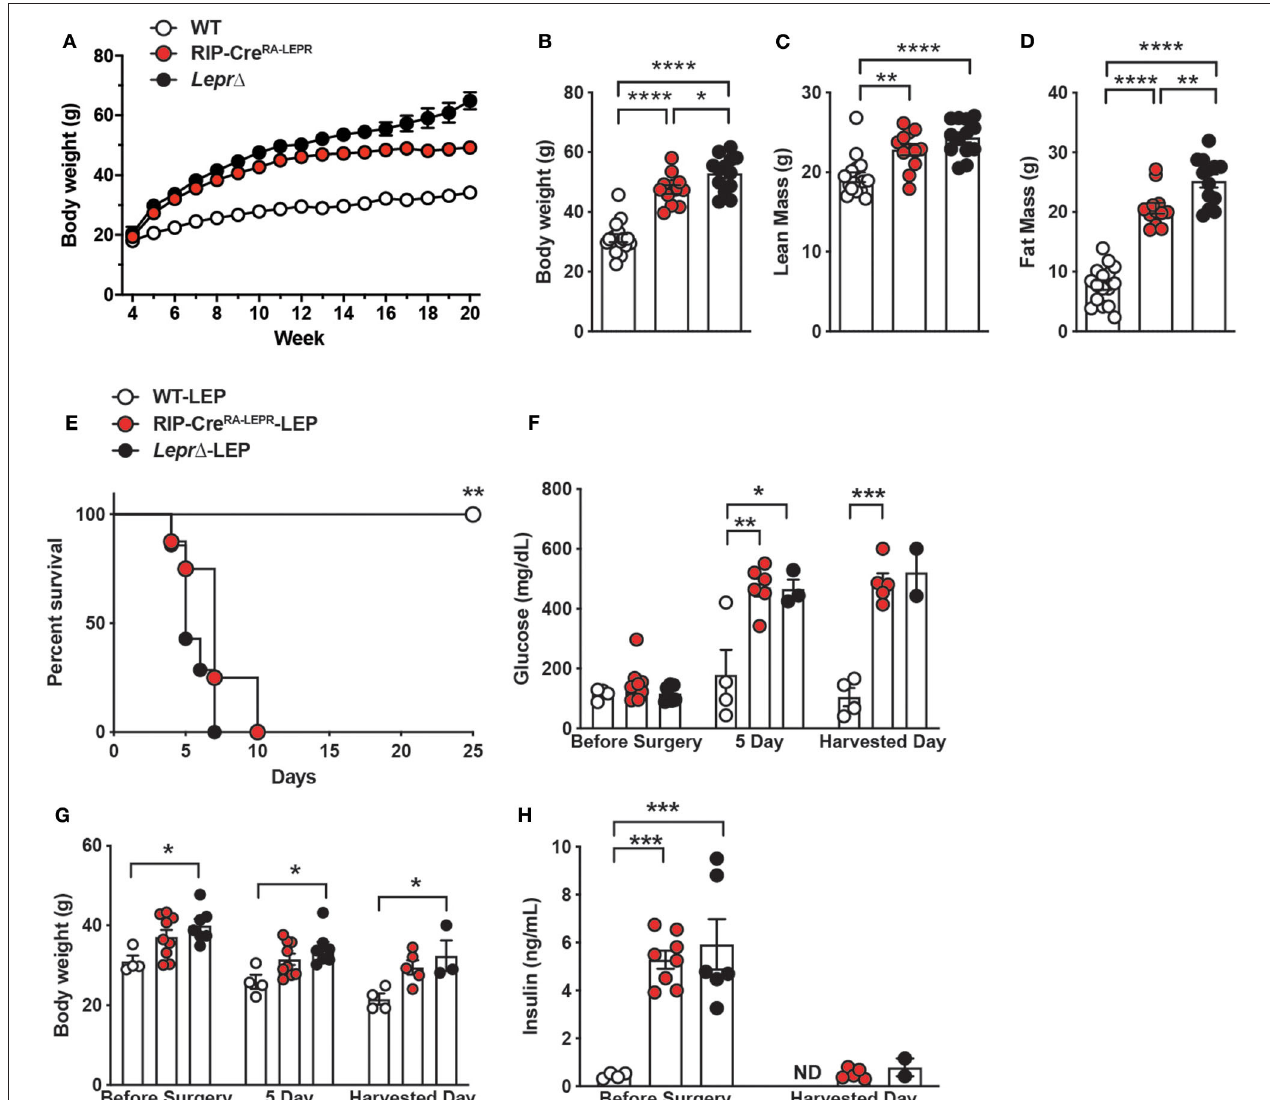
FIGURE 3 | Re-expression of LEPRs in RIP-Cre 25Mgn neurons is not sufficient for leptin to lower glucose in insulin-deficient mice. (A) The time course of body weight ( n = 16; WT, 12; RIP-Cre RA − LEPR , and 13; Lepr 1 ), (B) body weight ( n = 16; WT, 12; RIP-Cre RA − LEPR , and 13; Lepr 1 ), (C) lean mass ( n = 16; WT, 12; RIP-Cre RA − LEPR , and 13; Lepr 1 ), and (D) fat mass at 15–16 ( n = 16; WT, 12; RIP-Cre RA − LEPR , and 13; Lepr 1 ) weeks of ages of mice re-expressing LEPRs only in RIP-Cre 25Mgn neurons (RIP-Cre RA − LEPR ). Wild-type control (WT) was composed of RIP-Cre 25Mgn :: Lepr WT / WT and Lepr WT / WT , and Lepr loxTB / loxTB mice were used as LEPRs-deficient mice. (E) The survival percentage ( n = 4; WT-LEP, 9; RIP-Cre RA − LEPR -LEP, and 7; Lepr 1 -LEP at day − 1), (F) blood glucose ( n = 4; WT-LEP, 9; RIP-Cre RA − LEPR -LEP, and 7; Lepr 1 -LEP at day − 1, n = 4; WT-LEP, 5; RIP-Cre RA − LEPR -LEP, and 3; Lepr 1 -LEP at day 5, n = 4; WT-LEP, 4; RIP-Cre RA − LEPR -LEP, and 2; Lepr 1 -LEP at the harvest day), (G) body weight ( n = 4; WT-LEP, 9; RIP-Cre RA − LEPR -LEP, and 7; Lepr 1 -LEP at day − 1, n = 4; WT-LEP, 5; RIP-Cre RA − LEPR -LEP, and 3; Lepr 1 -LEP at day 5, n = 4; WT-LEP, 4; RIP-Cre RA − LEPR -LEP, and 2; Lepr 1 -LEP at the harvest day), and (H) plasma insulin levels ( n = 4; WT-LEP, 9; RIP-Cre RA − LEPR -LEP, and 7; Lepr 1 -LEP at day − 1, n = 4; WT-LEP, 5; RIP-Cre RA − LEPR -LEP, and 3; Lepr 1 -LEP at day 5, n = 4; WT-LEP, 4; RIP-Cre RA − LEPR -LEP, and 2; Lepr 1 -LEP at the harvest day) in insulin-deficient RIP-Cre RA − LEPR mice chronically administered leptin into the lateral ventricle (25 ng/0.11 µ L/h). Harvested day means the date of death of succumbed RIP-Cre RA − LEPR -LEP and Lepr 1 -LEP mice and 25 days for WT-LEP. Values are mean ± S.E.M. **** p < 0.0001, *** p < 0.001, ** p < 0.01, * p < 0.05. One way ANOVA followed by Tukey’s multiple comparison test (B–D,F–H) and Log-rank (Mantel-Cox) testing (E) was used to analyze the